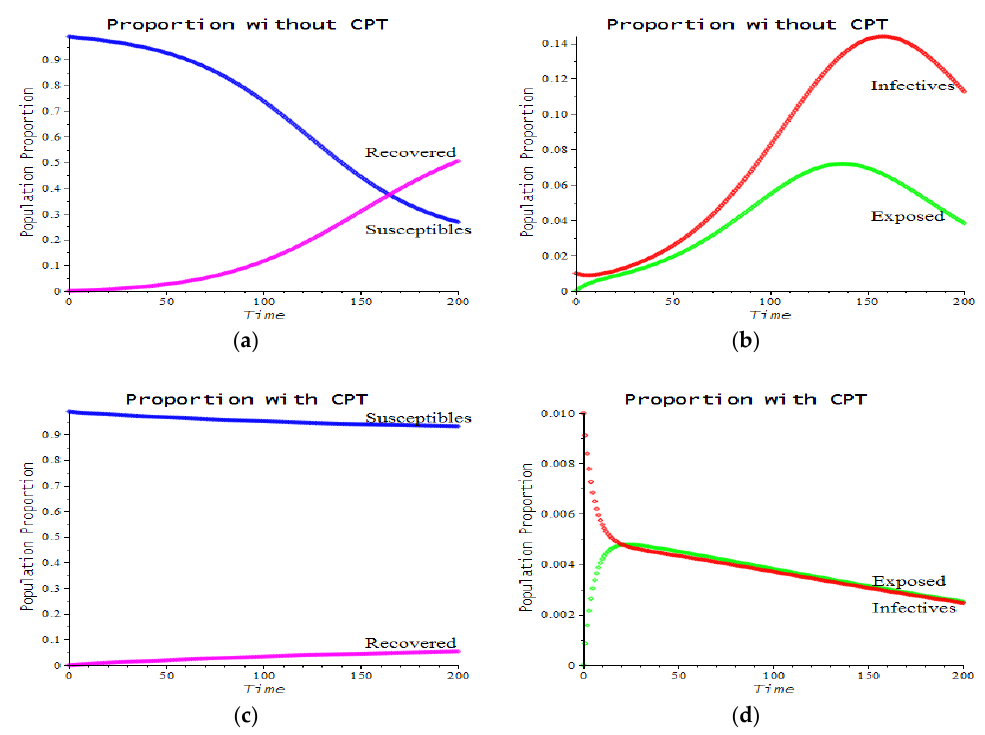
Figure 4. A graph of the SEIR model without CPT (top figures) showing the susceptible and recovered classes ( a ) and the exposed and infective classes ( b ) as in Figure 2 but with a shorter time horizon. ( c , d ) With CPT. The bottom figures show similar graphs for the SEIR model with CPT as in Figure 3 but with a shorter time horizon.